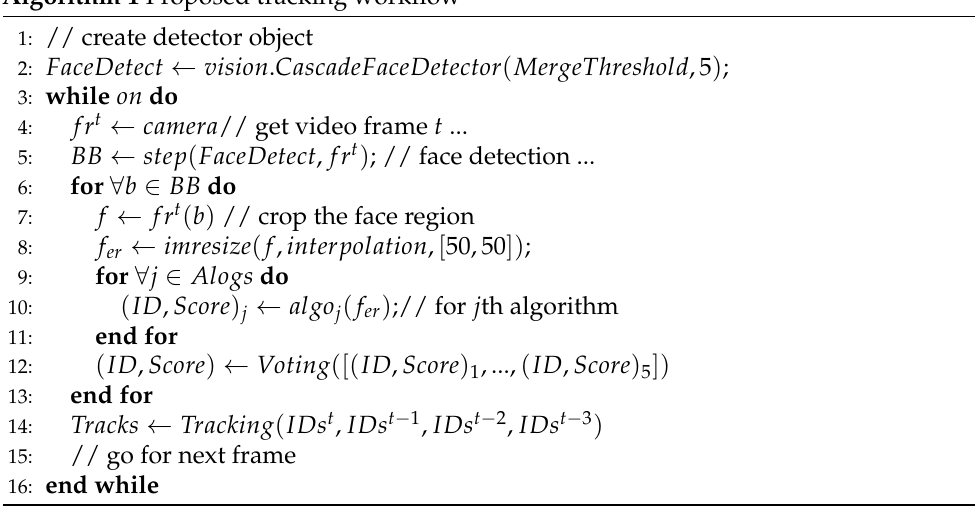
Algorithm 1 Proposed tracking workflow